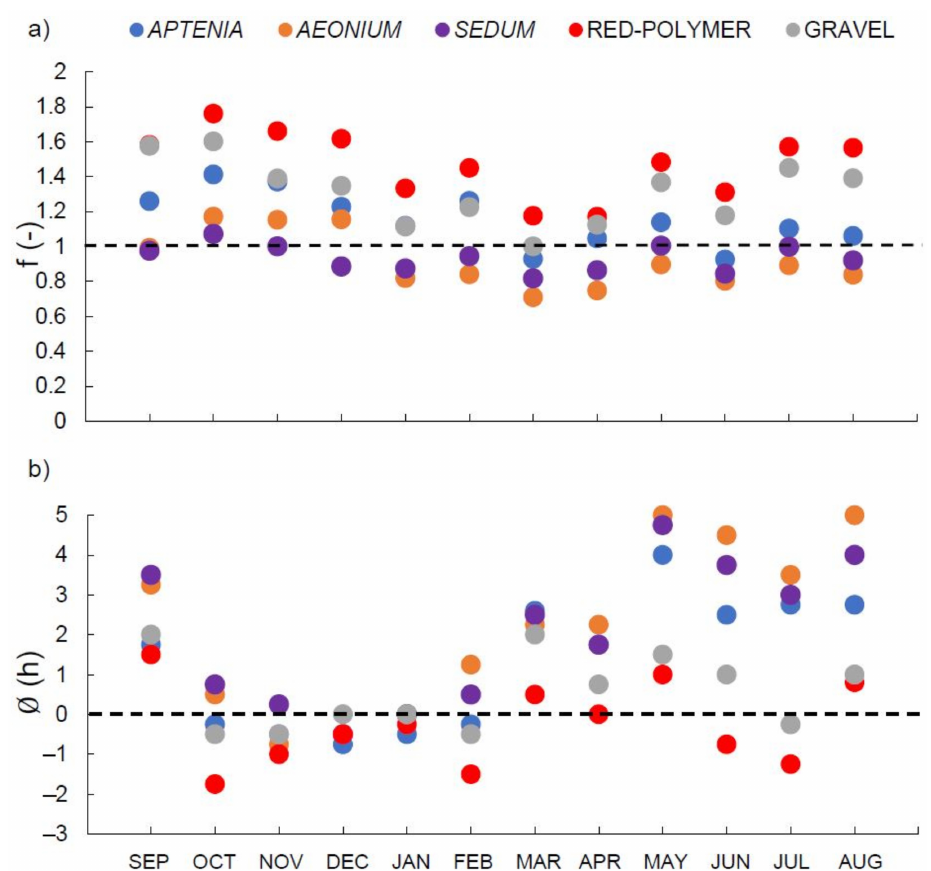
Figure 5. a) Decrement factor and b) time lag for conventional (red-polymer and gravel) and green covers ( Aptenia , Aeonium , and Sedum ). Dashed lines are plot as a reference with respect to ambient (f = 1, Ø =